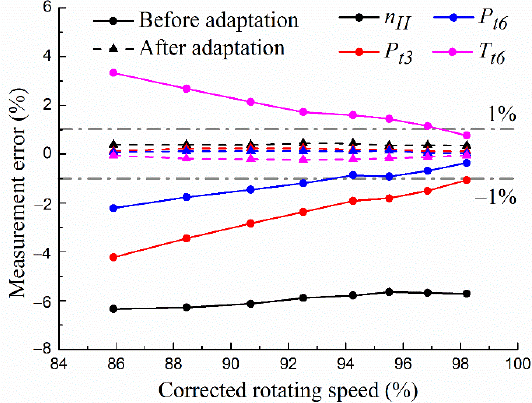
Figure 12. Absolute error comparison.